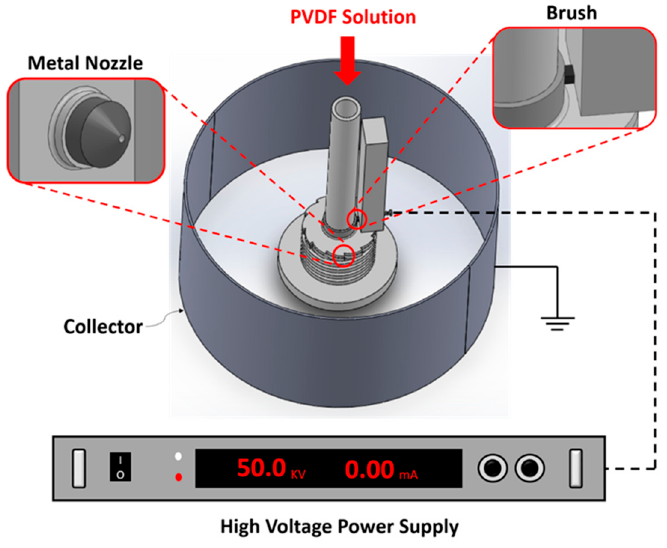
Figure 1. Schematic of the multinozzle far-field centrifugal electrospinning setup to fabricate the polyvinylidene fluoride (PVDF) nanofibers.